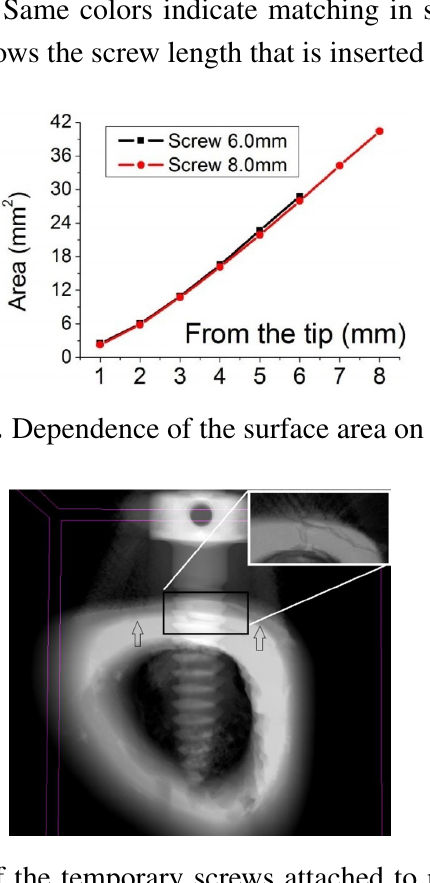
Figure 6. Micro-CT scan of the temporary screws attached to rabbit’s tibia after 1 week. Cortical and cancellous bone limits are identified by arrows. Detail of fractured bone due high stress induced during mini-implant insertion at increasing magnification.